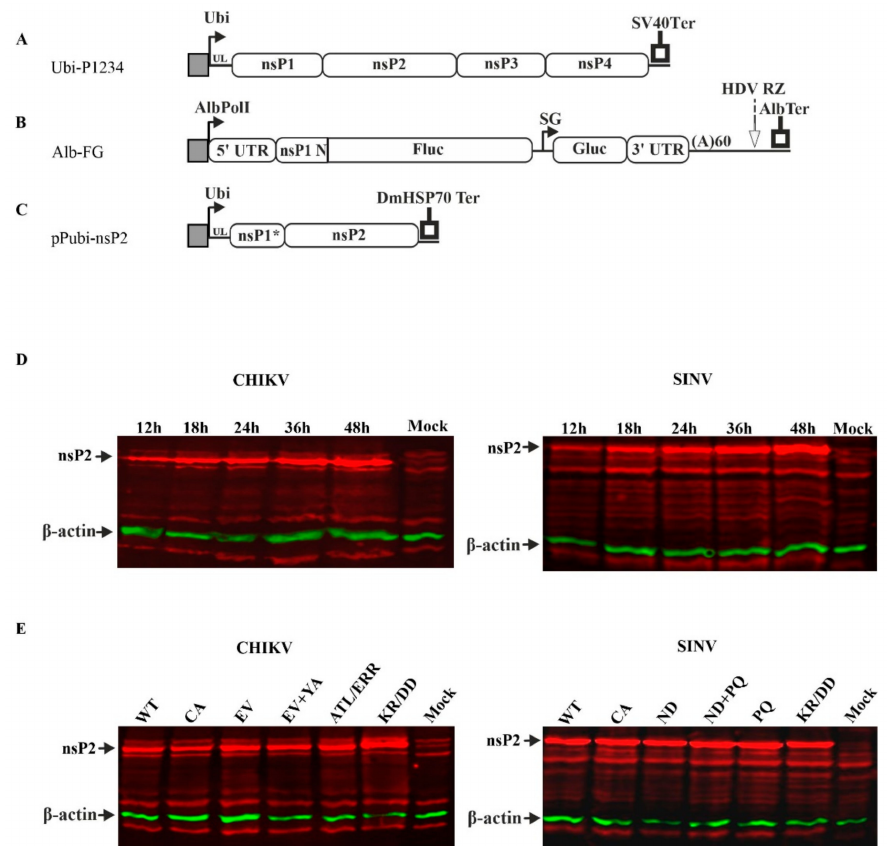
Figure 1. Schematic overview of used plasmids and verification of nsP2 expression in transfected C6/36 cells. ( A ). Trans-replicase plasmid for expression of alphavirus ns-polyprotein.